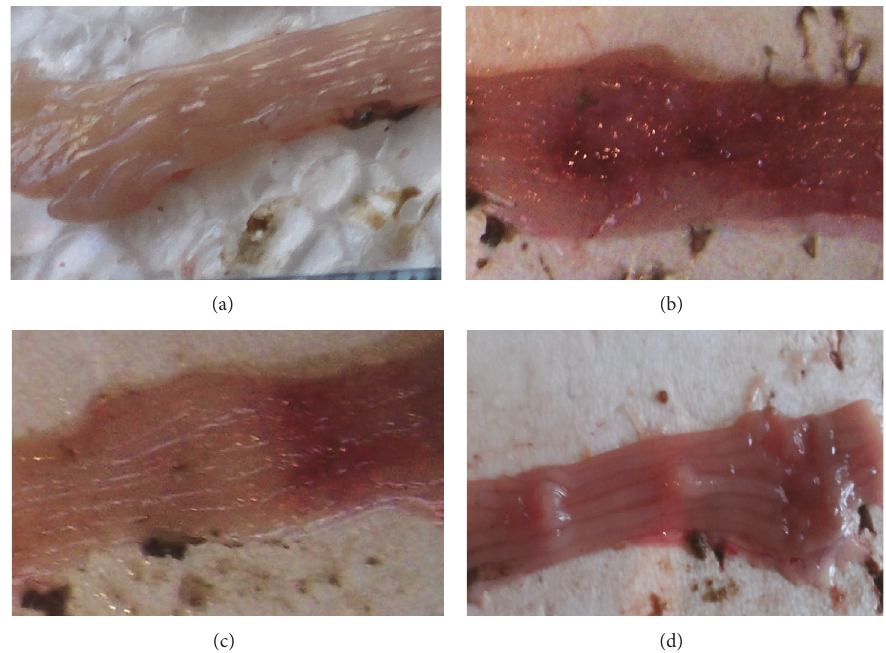
Figure 2: Macrophotographs of bowel internal sides for rats experienced UC and treated with Prednisolone and MI-1. (a) Control group, (b) UC group, (c) UC + Prednisolone group, and (d) UC + MI-1 group.